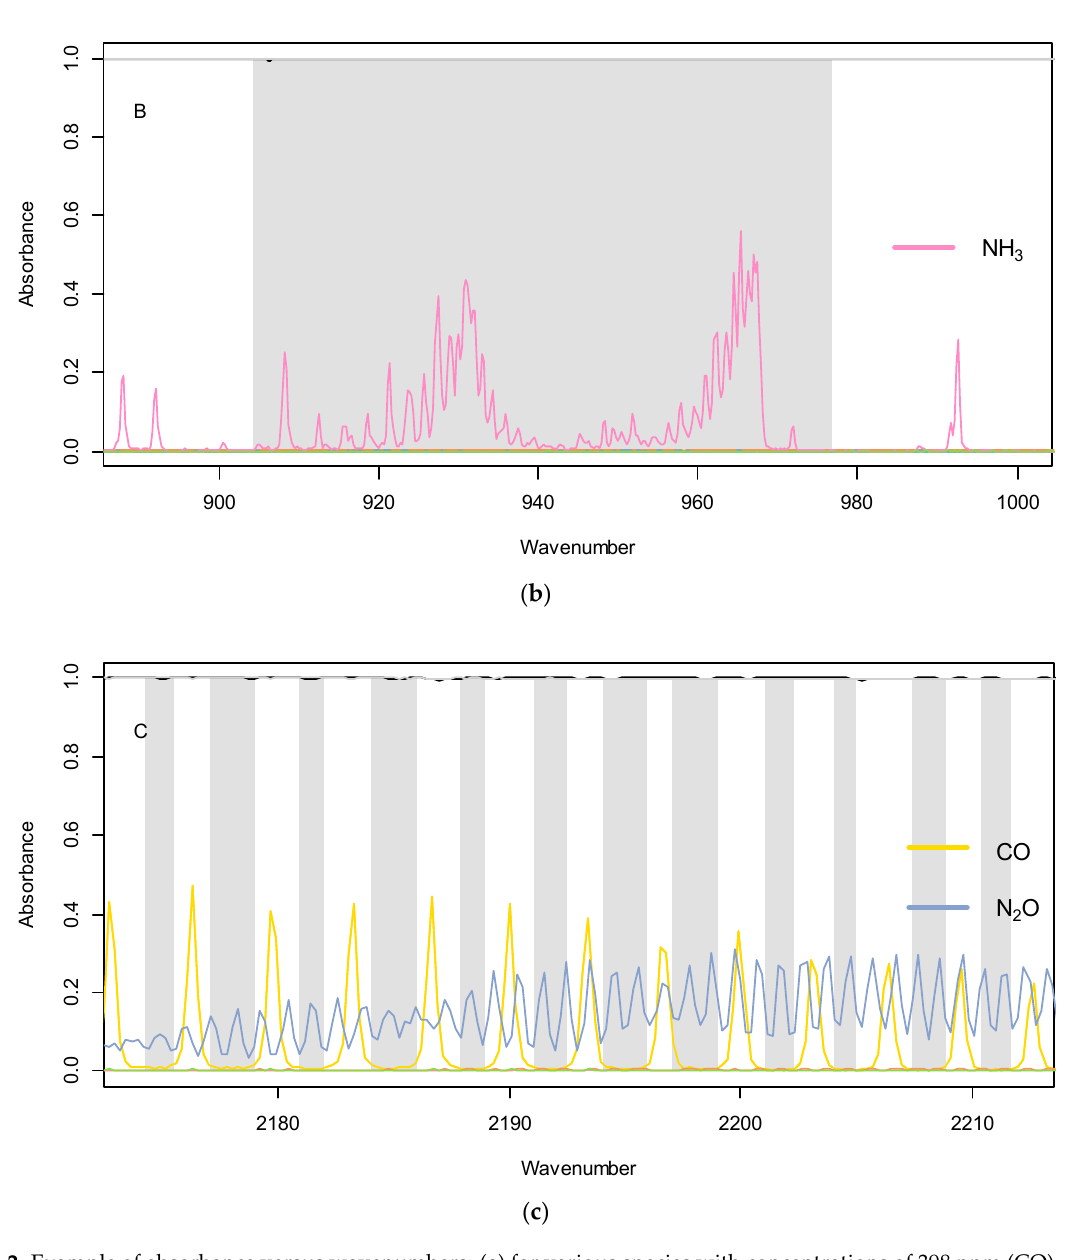
Figure 2. Example of absorbance versus wavenumbers: ( a ) for various species with concentrations of 398 ppm (CO), 97 ppm (NO), 136 ppm (NO 2 ), 93 ppm (N 2 O), 93 ppm (NH 3 ), 0.8% (CO 2 ), 2.03% (H 2 O). For better visualization, the spectra of H 2 O and CO 2 were reduced by a factor of 10 and displayed in an inverted axis. For the same reason, NH 3 and HCN spectra were increased by a factor of 2 and 4, respectively; ( b ) NH 3 , area B of panel ( a ); ( c ) N 2 O, area C of panel ( a ).